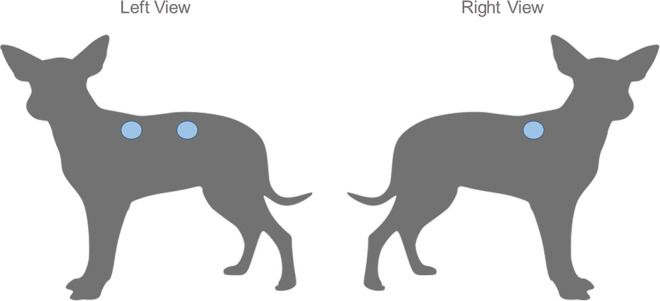
Anatomical disposition of the standardized dermal wounds in dogs. Three standardized dermal wounds induced in the dorsal region of each animal between the first thoracic vertebra and the fifth lumbar vertebra, 5 cm from the cervical spine, and 10 cm apart, two in the left side and one in the right side.